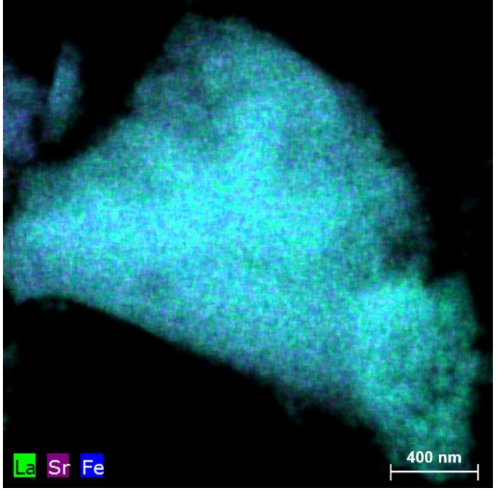
Figure 4. HAADF-STEM mapping image of La 0.75 Sr 0.25 FeO 3